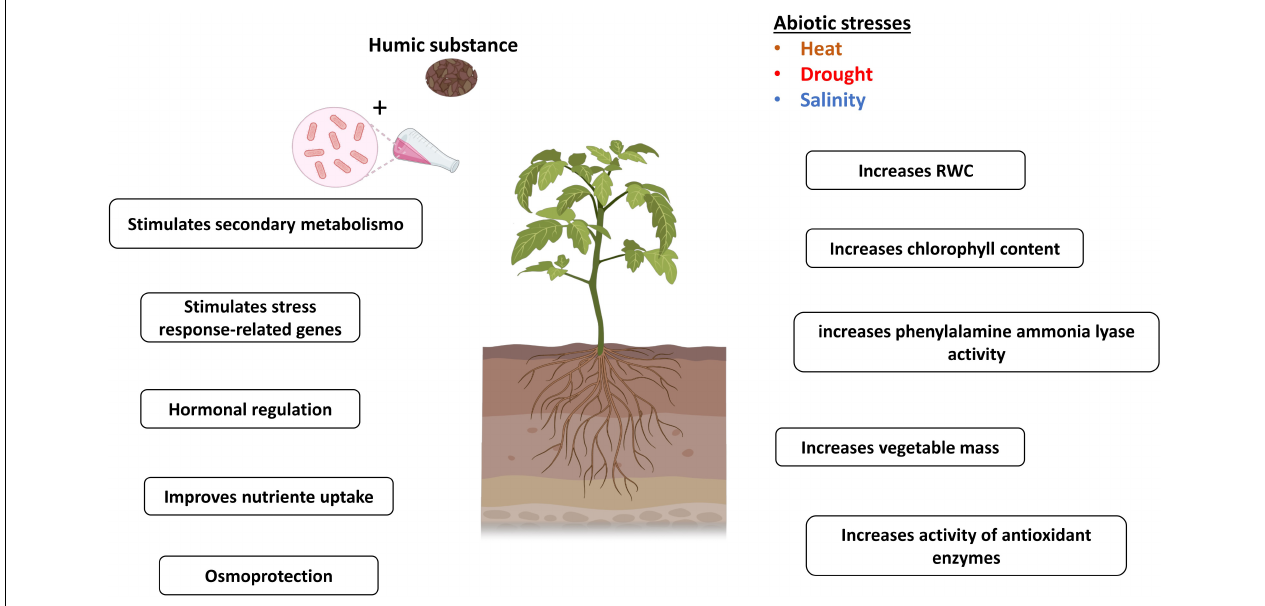
FIGURE 4 | Mechanisms related to plant tolerance to abiotic stress mediated by HSs and PGPB. Figure created using BioRender (https://biorender.com/).